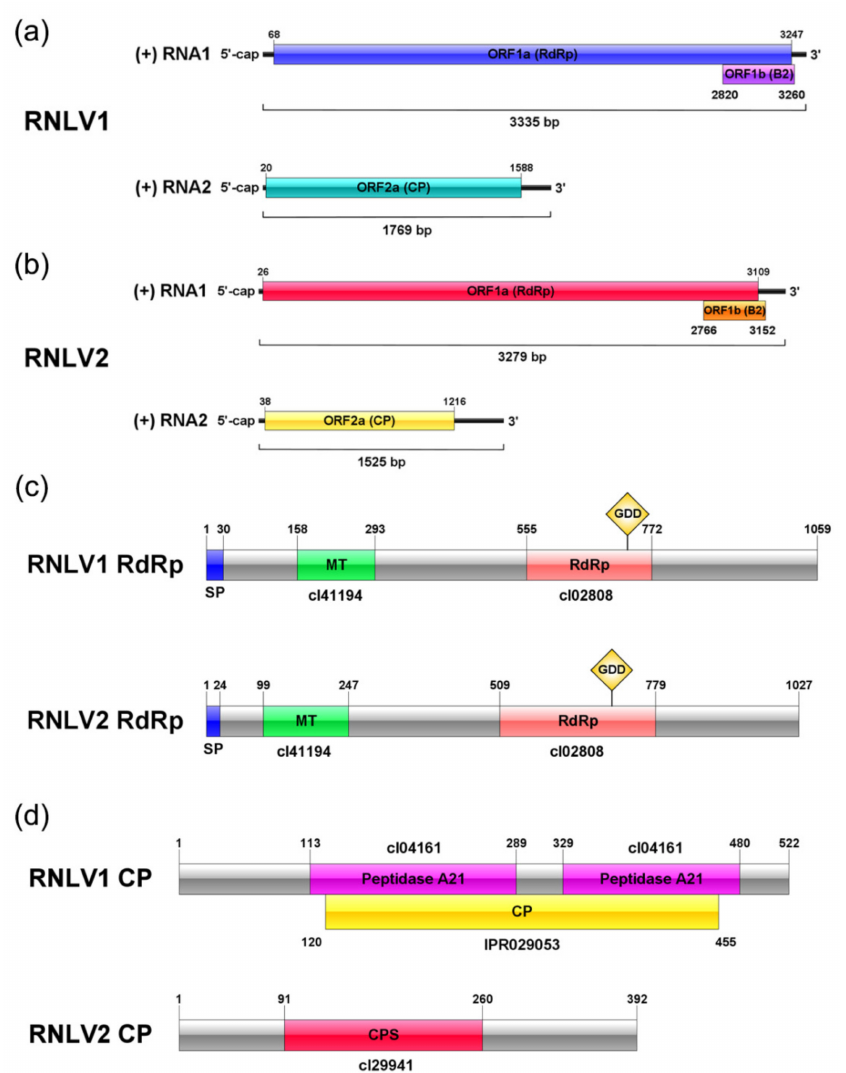
Figure 2. Genome organizations and protein domains of RNLV1 and RNLV2. ( a ) Genome organi- zation of RNLV1. The predicted ORFs are shown in rectangles with different colors. ( b ) Genome organization of RNLV2. The predicted ORFs are shown in rectangles with different colors. ( c ) Two predicted domains in the RdRps of RNLV1 and RNLV2. The predicted domains are presented in rectangles with different colors. The domain accession numbers in CD database of the predicted domains are shown below the corresponding rectangles. SP, Signal peptide; MT, nodavirus vmethyl- transferase domain; RdRp, RNA-dependent RNA polymerase domain; GDD, the conserved GDD box in the RdRp domain. ( d ) Predicted domains in the RNLV1 and RNLV2 CPs. The predicted CPs and domains are shown in rectangles with different colors. The domain accession numbers in CD and InterPro database are indicated above or below the corresponding rectangles. Peptidase A21, Peptidase family A21 domain; CP, coat protein domain; and CPS, coat protein s